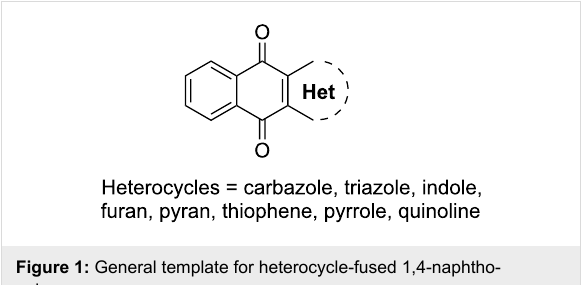
Figure 1: General template for heterocycle-fused 1,4-naphtho-